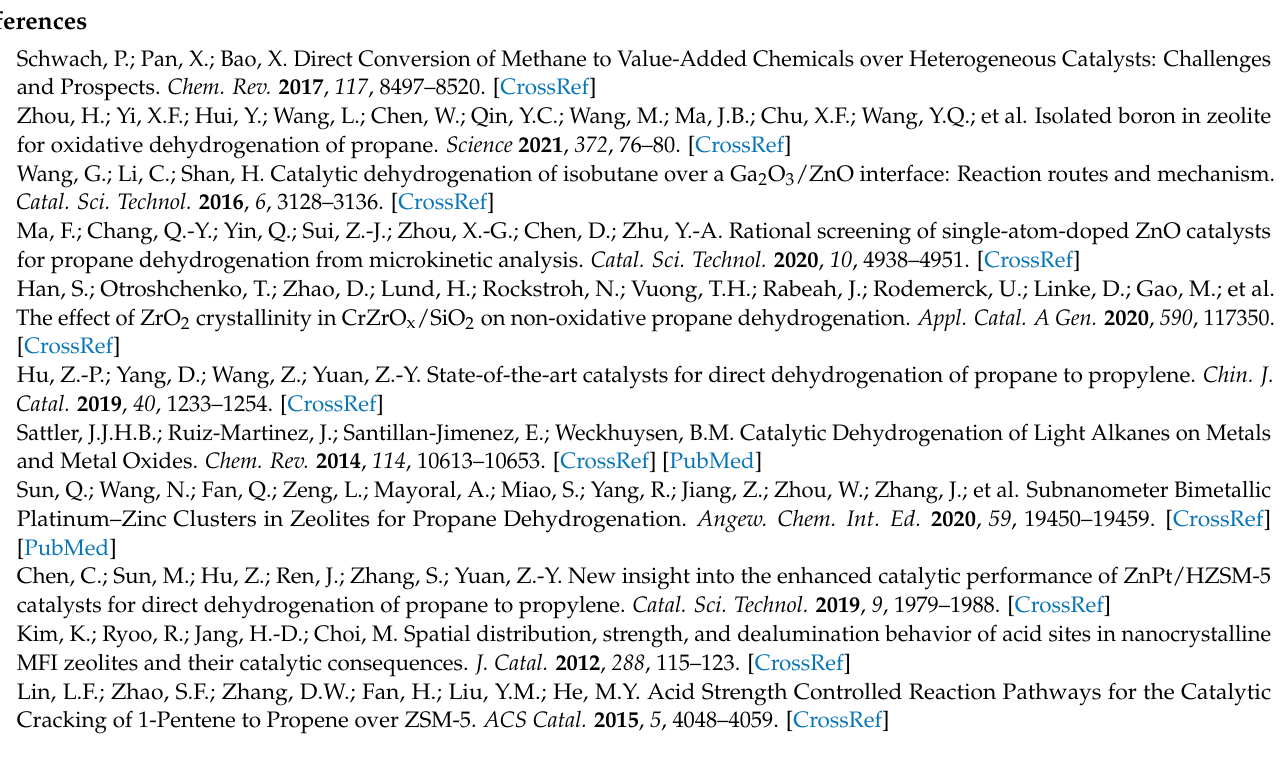
Figure S2: The particle size distribution of the loaded metals from TEM images. (a): Zr/HZSM-5; (b): Co/HZSM-5; (c): Mo/HZSM-5; (d): Ga/HZSM-5: (e): Zn/HZSM-5; Figure S3: The XPS spectra of the